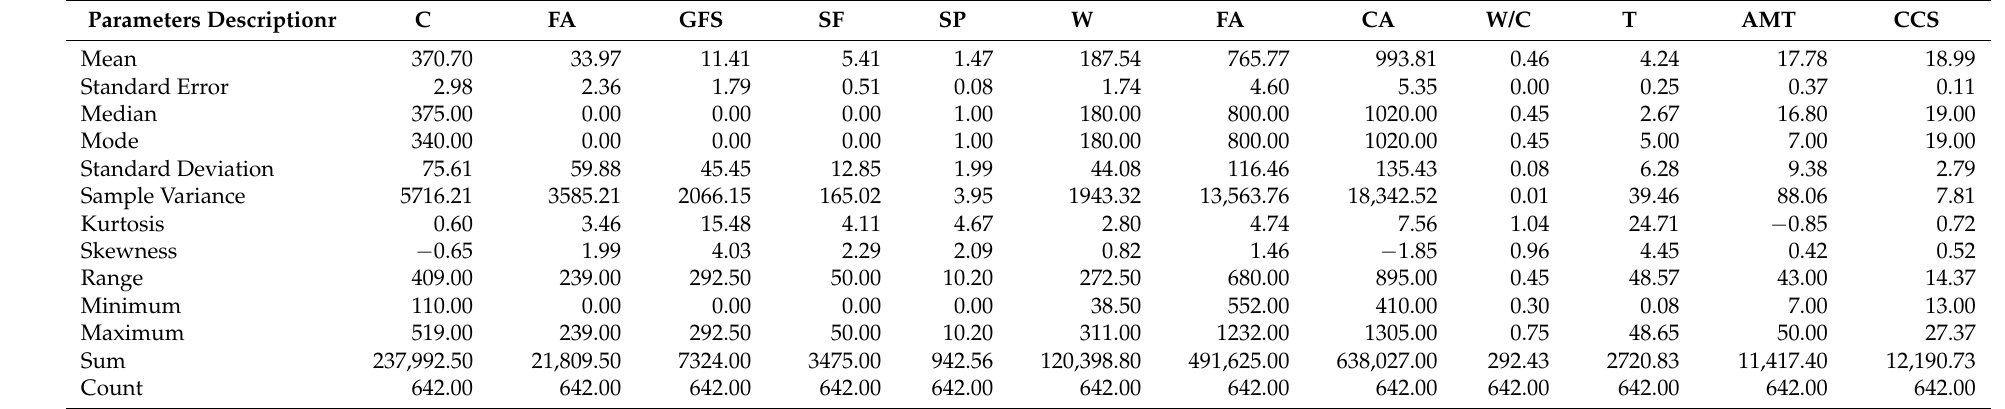
Table 3. Descriptive analysis of